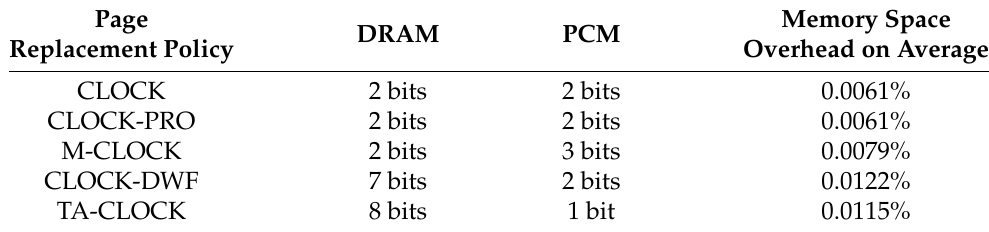
Table 8. Comparison of memory space overhead for each page replacement